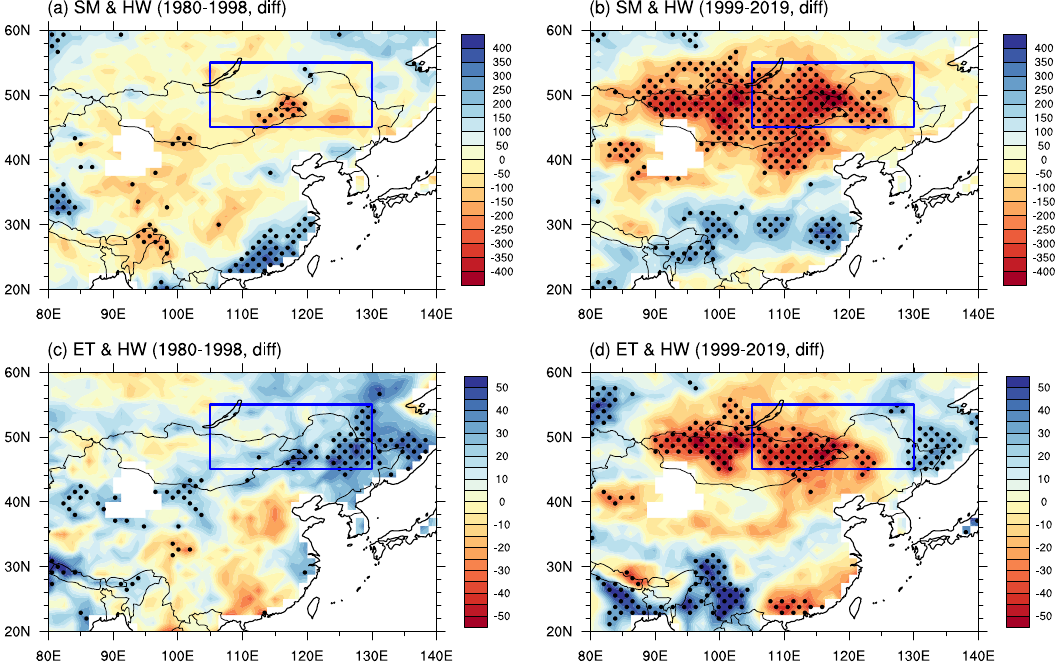
Fig. 4 Regression of heatwave frequency against seasonal differences of SM and ET. Regression of heatwave frequency against the seasonal differences of ( a , b ) soil moisture and ( c , d ) evapotranspiration between summer (JJA) and spring (MAM) during ( a , c ) 1980 – 1998 and ( b , d ) 1999 – 2019. The dots denote the 95% con fi dence level based on the P